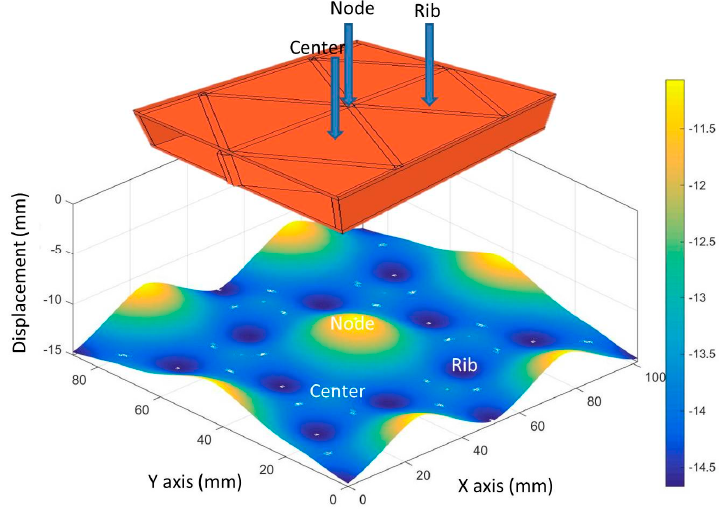
Figure 6. The contour of typical maximum displacement for panel at different impact